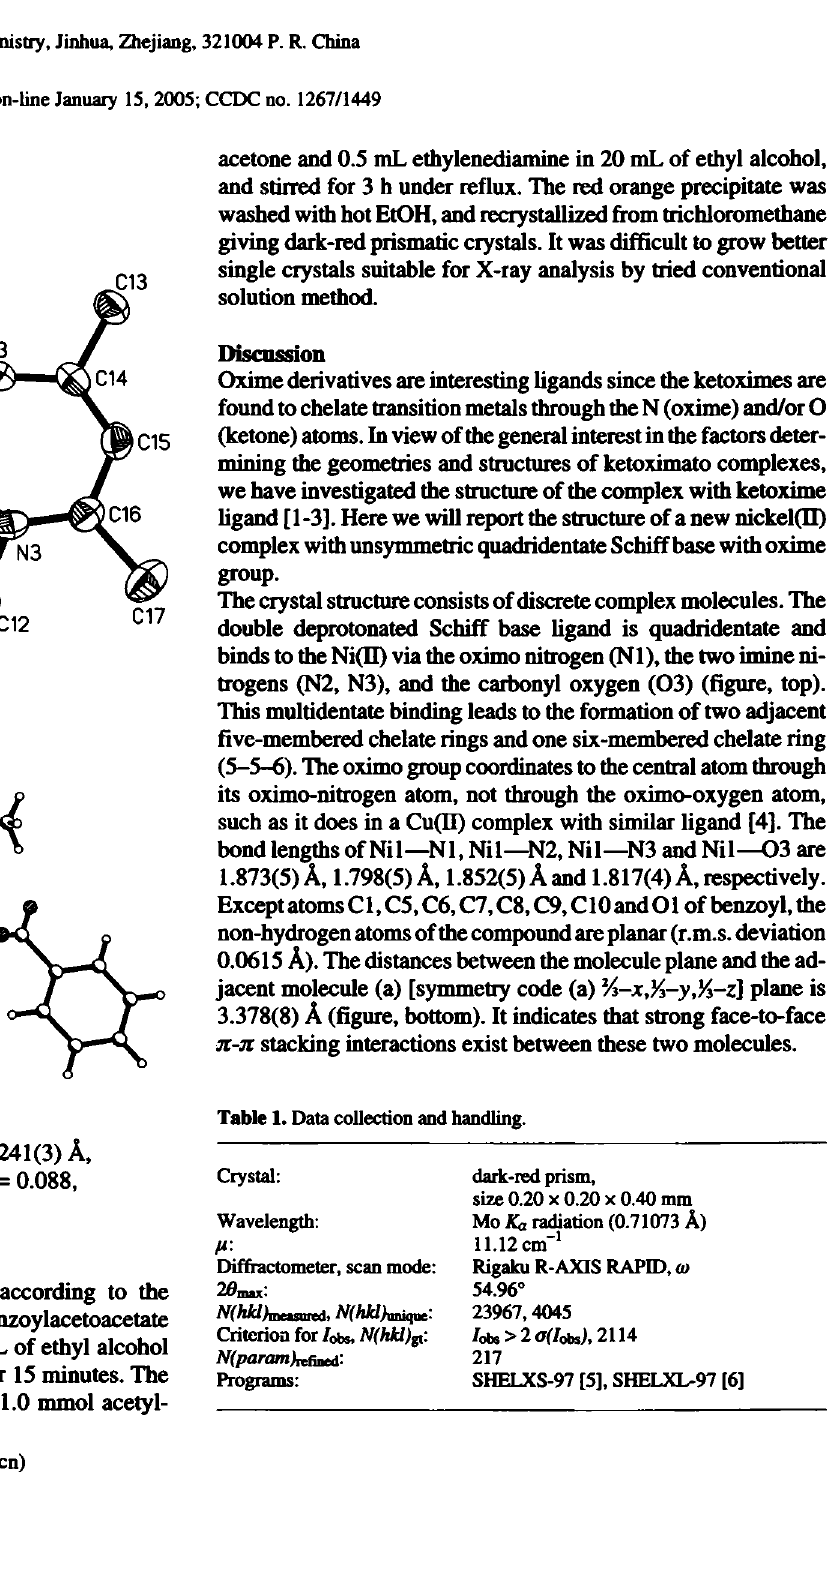
Table 1. Data collection and handling.